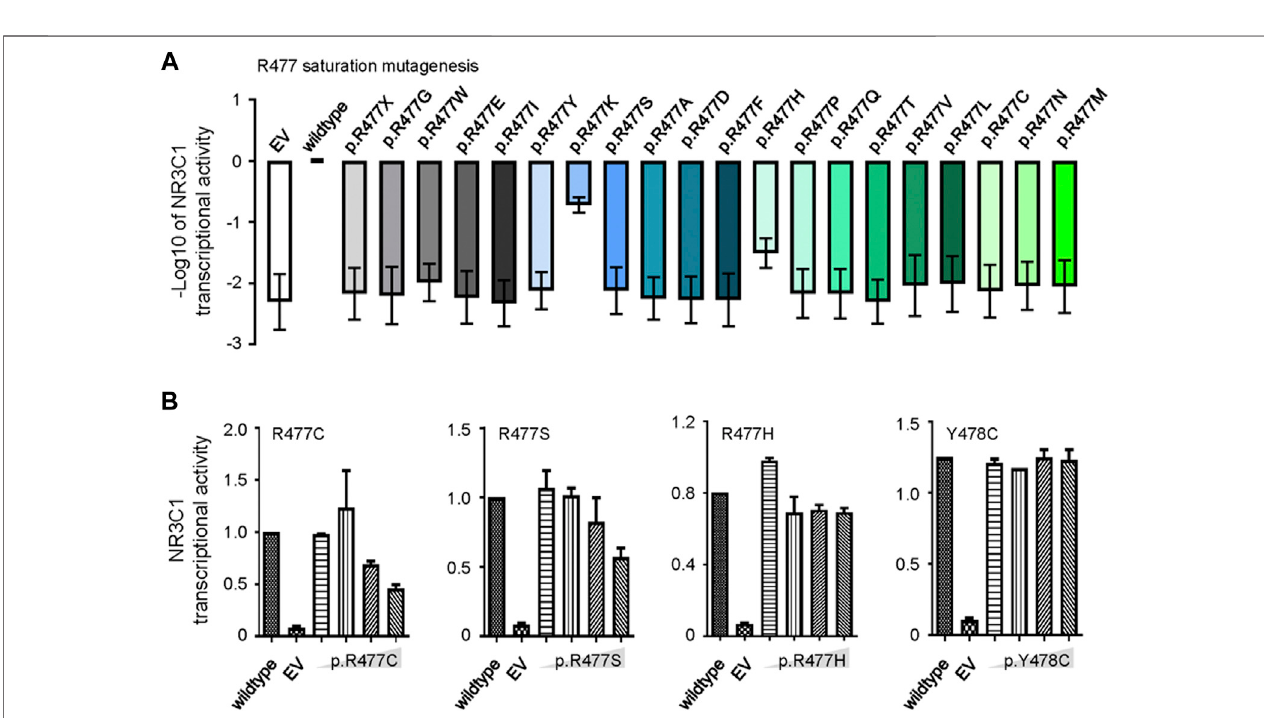
FIGURE 3 | Saturation mutagenesis of NR3C1 R477 and its effects on protein function. (A) Twenty R477 mutation types were constructed by saturated mutagenesis.ThetranscriptionalactivityofNR3C1mutationswaspresentedasthe − log10valueofrelativeactivity. (B) Wild-typeandR477mutant(p.R477C,p.R477S, p. R477H, and p. Y478C) NR3C1 were co-transfected in different proportions (1:1, 1:2, 1:4, and 1:8). Mutated NR3C1 (p.R477C and p. R477S) showed dominant- negative regulatory effects on the transcriptional activity of wild-type NR3C1, while mutant NR3C1 (p.R477H and p. Y478C) showed non-dominant-negative regulatory effects on the transcriptional activity of wild-type NR3C1. All data are presented as means ± SD of triplicate samples from each independent experiment.